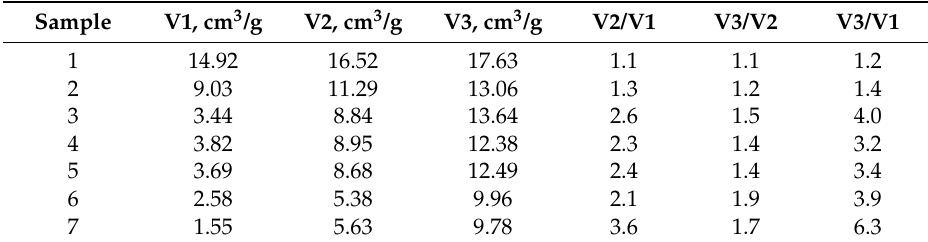
Table 3. The volumes of propylene sorbed on coals of various grain class: 0.500–0.700 mm